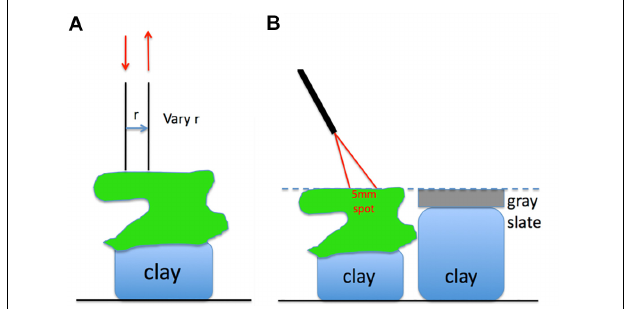
FIGURE 1 | (A) Two optical fibers measure the lateral spread of light within the coral. (B) An optical fiber probe delivers to and collects from a 5-mm-dia. spot on the coral, at a 30 ◦ angle off the normal to the coral